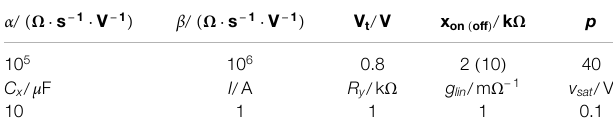
TABLE 3 | Setting of speci fi c M-CNN cell circuit parameters, speci fi cally α , β , and V t from Eq. 25 , x on , x off , and p from Eqs. 26 , 27 , C x from Eq. 19 , I from Eq. 4 , R y from Eq. 2 , as well as g lin and v sat from Eq. 3 , which are kept unchanged in the design examples to